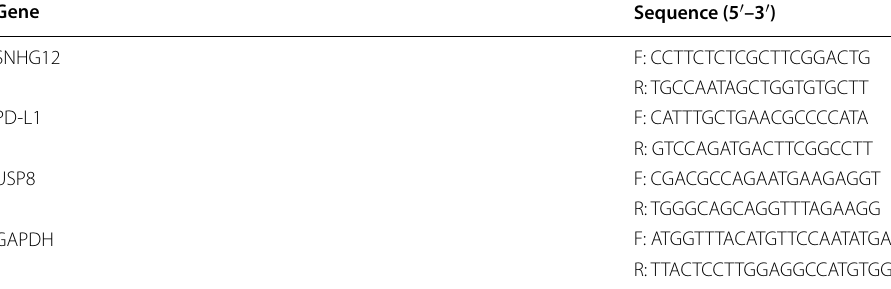
Table 1 PCR primer sequences